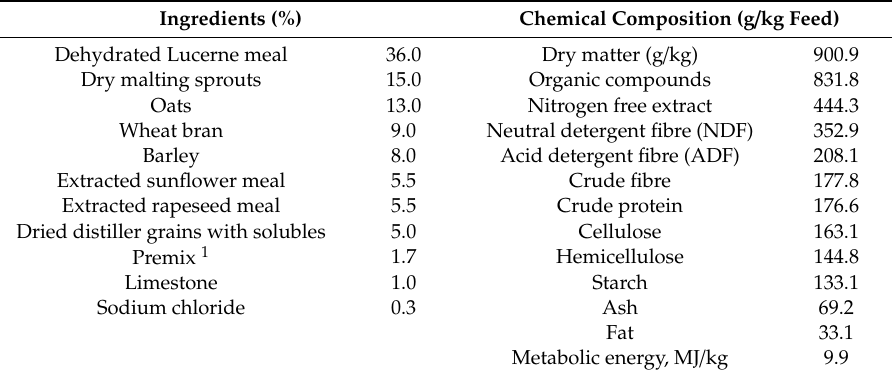
Table 1. Ingredients and chemical composition of rabbit